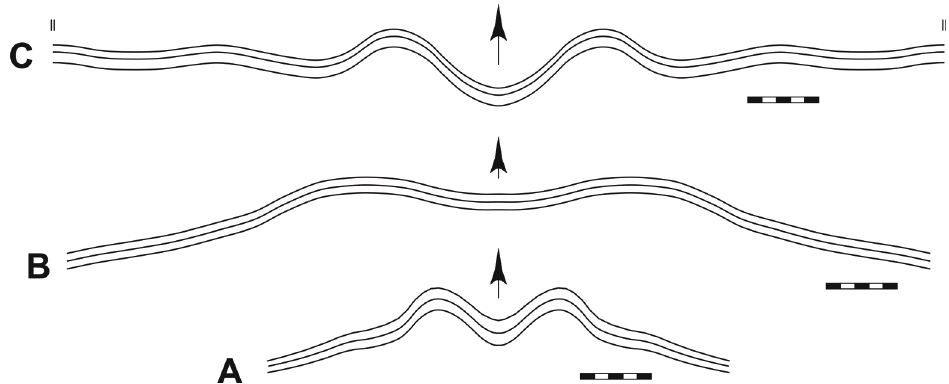
Fig. 18. Ancistroceras undulatum (Boll, 1857), lirae course in selected specimens. A . Specimen MB.C.30522 (Neben & Krueger Coll.) from Juszkowo (former Gischkau), Gdańsk County (Pomerania, Poland), at wh = 10 mm. B . The same specimen, at wh = 27 mm. C . Specimen MB.C.30521 (Neben & Krueger Coll.) from Oderberg (Brandenburg), at wh = 18 mm. Scale bar units = 1